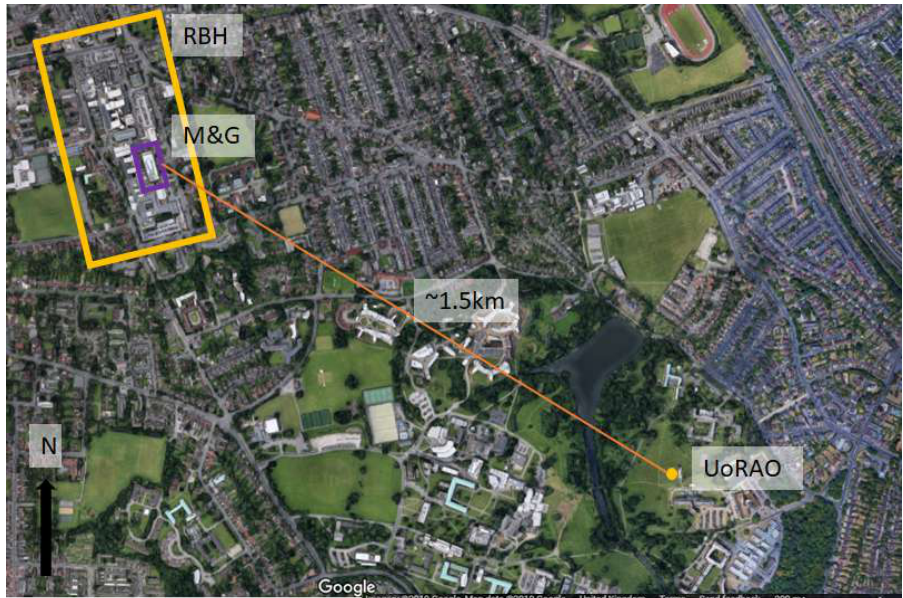
Figure 4. Location of the University of Reading Atmospheric Observatory (UoRAO, dot) in comparison to the Royal Berkshire Hospital site (RBH, box). The Maternity and Gynaecology (M and G) building (Figure 1) is highlighted within the RBH site.